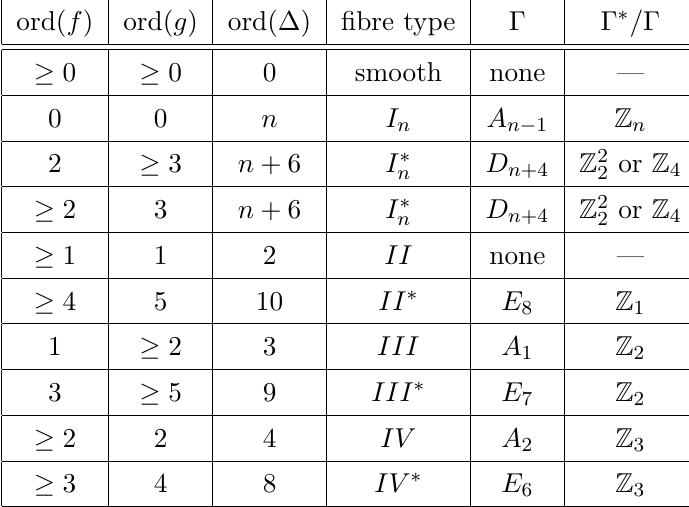
Table 1 . The classification of reducible fibres in terms of the vanishing degree of f , g and ∆ and the associated ADE root lattices. The last column denotes the centres of those lattices, which for I ∗ depends on whether n is even or